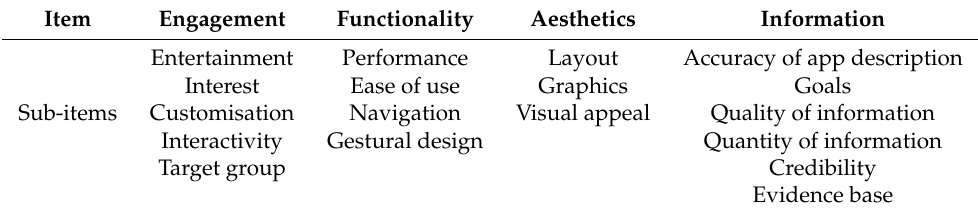
Table 1. MARS objective quality categories (item) and respective sub-categories (sub-items). Adapted from Stoyanov and colleagues